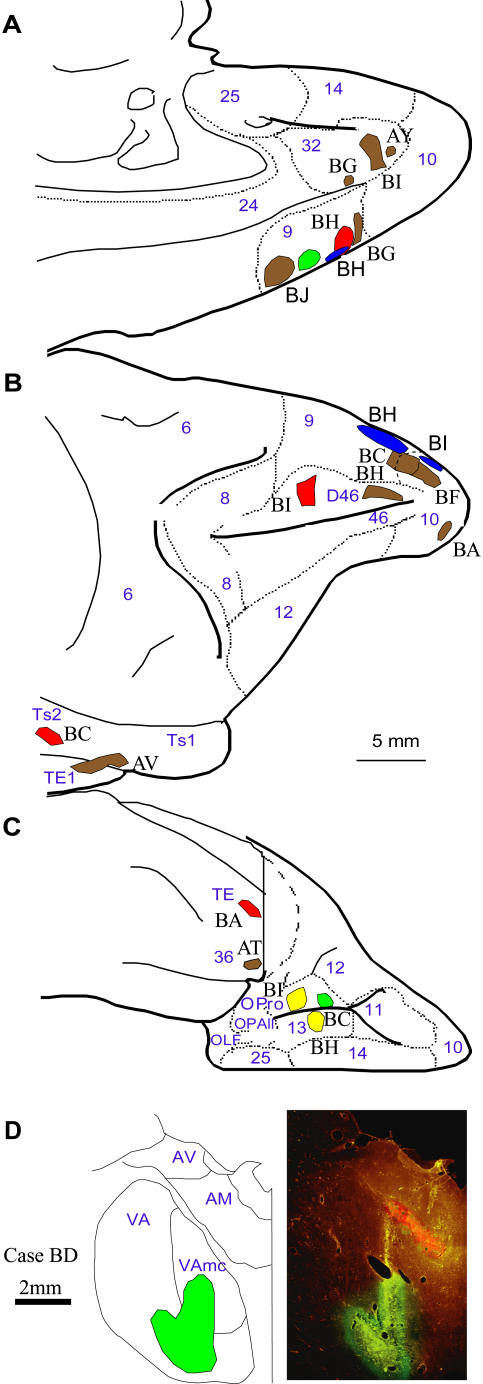
Composite of cortical and thalamic injection sites.Cortical injection sites shown on the A, medial, B, lateral, and C, basal surfaces of the brain of the rhesus monkey. D, Representative coronal section through the thalamus (photomicrograph on the right column and corresponding outlines on the left column). The red fluorescence in the anterior medial thalamic nucleus is from a fluororuby injection, which was not used in this study. Case names appear in black; Names of areas and nuclei in A-D are in blue. Abbreviations: AM: anterior medial nucleus; AV: anterior ventral nucleus; VA: ventral anterior nucleus; VAmc: ventral anterior nucleus, pars magnocellularis; OLF: olfactory cortex; OPAll: orbital periallocortex; OPro: orbital proisocortex.